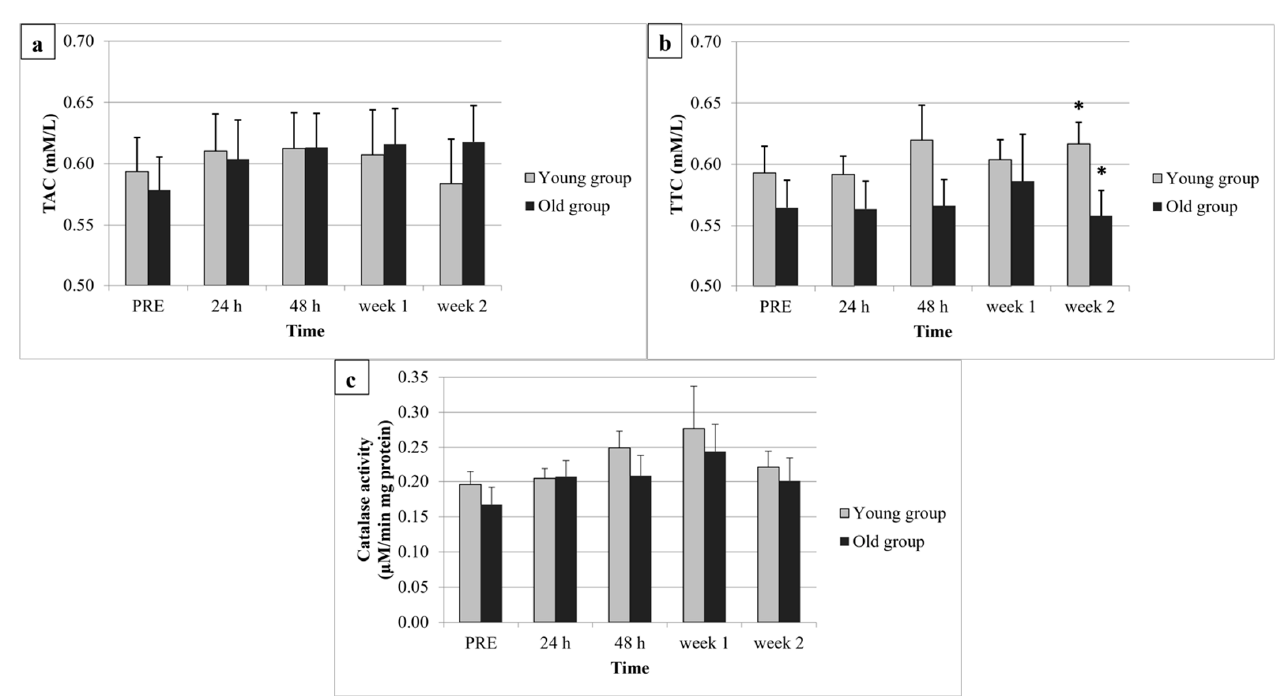
Figure 2. Plasma total antioxidant capacity ( a ), thiol concentration ( b ) and serum catalase ( c ) during the two-week training period among old and young groups. MEAN and SEM were calculated from four independent experiments/samples. TAC = total antioxidant capacity, TTC = total thiol concentration, * Significant ( p < 0.05) difference between the two groups.